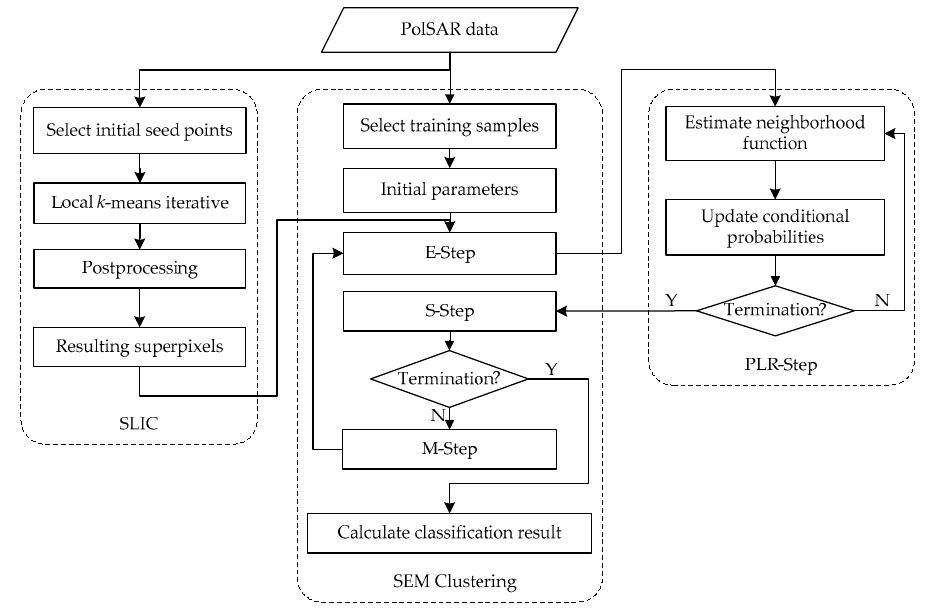
Figure 1. Overview of the proposed contextual SEM algorithm for PolSAR data classification. SLIC, simple linear iterative clustering.